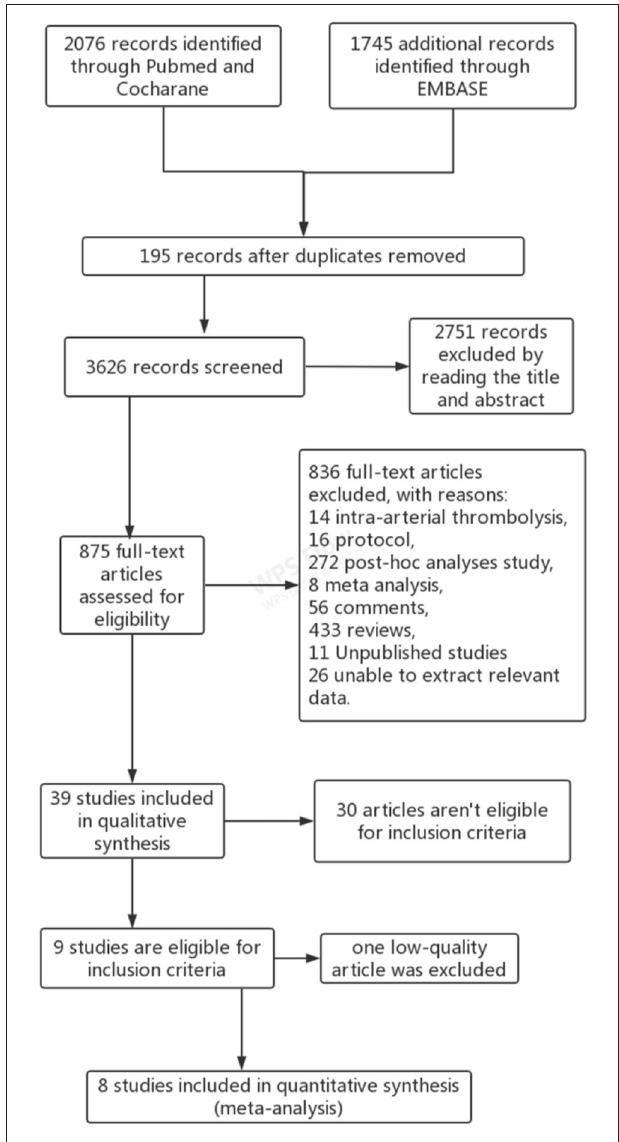
FIGURE 1 | Flow diagram of study identification and selection.